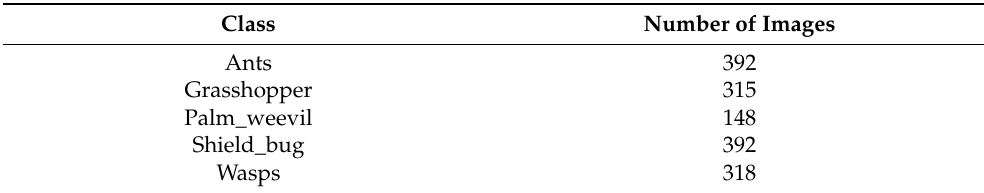
Table 1. Tabulated form of the self-created